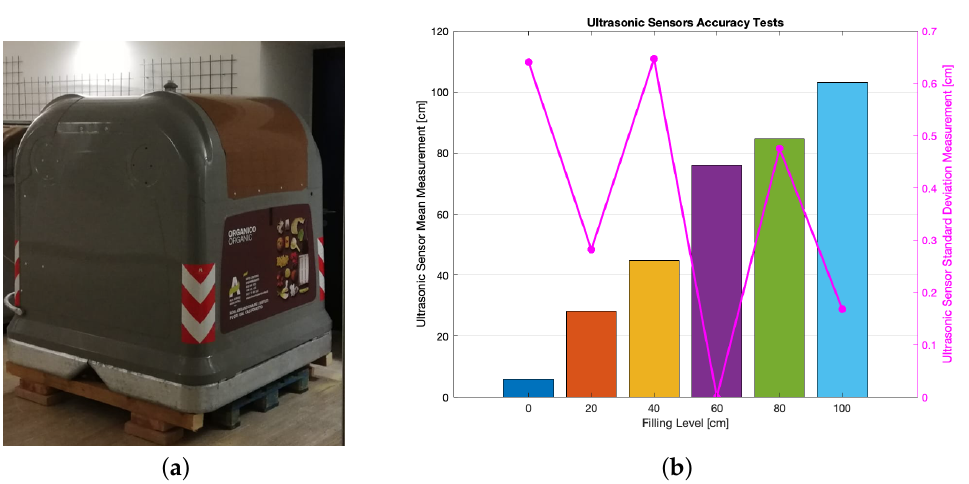
Figure 7. Ultrasonic sensor accuracy tests: ( a ) smart drop-off container indoor installed; ( b ) filling level trend throughout the various